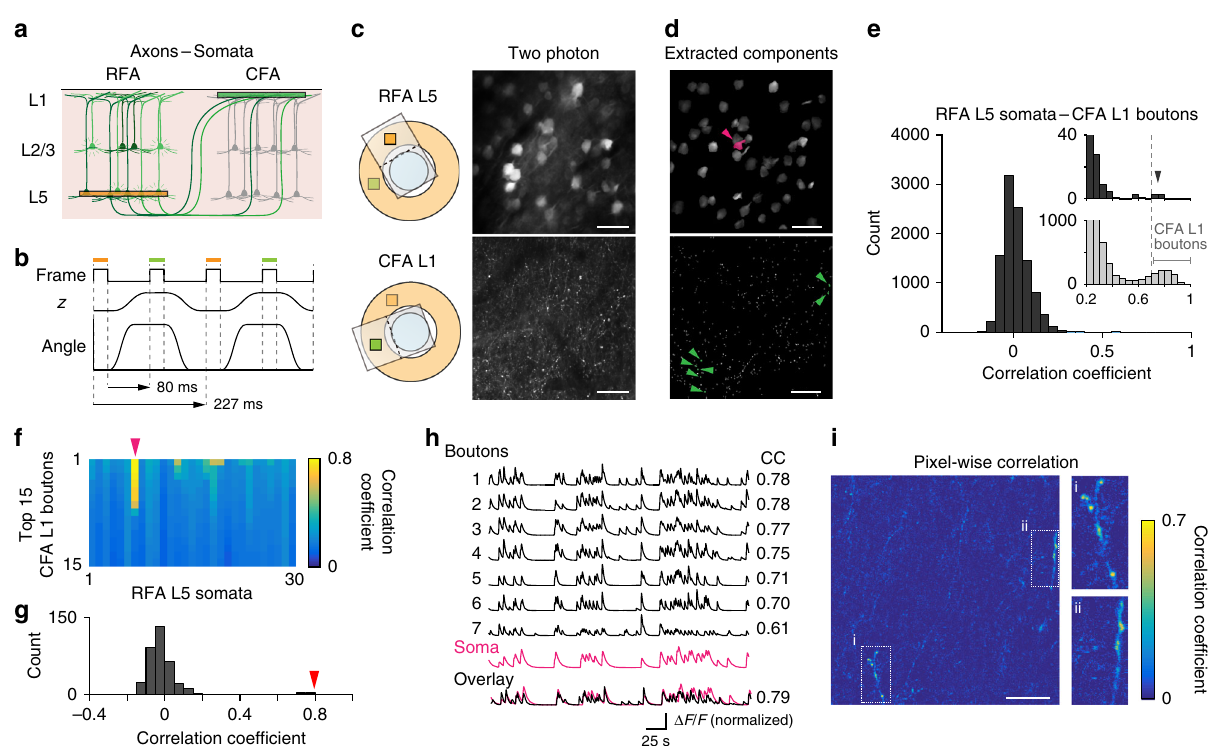
Fig. 6 Dual- fi eld imaging of neuronal somata and their projecting axons. a Schematic illustration of imaging fi elds (green, CFA; orange, RFA). b Timing chart during four consecutive imaging frames. c Left, schematic illustration of the FOV and device position at each imaging frame. Right, averaged two-photon images of GCaMP6s-expressing neuronal somata and axons. The depths of the fi elds in RFA L5 and CFA L1 were 450 and 25 µ m, respectively. Scale bar, 50 µ m. d All spatial components were extracted using the CNMF algorithm. Each component properly captured the structure of the neuronal soma and axonal bouton. Scale bar, 50 µ m. e Histogram of pairwise correlation coef fi cients (CCs) in inferred spike events between the RFA L5 somata and CFA L1 boutons with >10 spike events. The upper right inset is an enlarged view of the histogram. The right middle inset is a histogram of CCs between CFA L1 boutons (gray bars). f CFA boutons with the top 15 CCs against each RFA soma are sorted in descending order of the CC values. A magenta arrowhead indicates the same neuronal soma as in d . g Histogram of CCs of the RFA L5 somata indicated by the magenta arrowhead in d and f against all CFA L1 boutons. A red arrowhead indicates the position of the top CCs (0.78). The standard deviation of the distribution was 0.12. h Representative Δ F/F (temporal components) traces of seven CFA boutons (black) that showed high CCs against the trace of the neuronal soma shown in g (magenta). The amplitude was normalized to the maximum Δ F/F . Positions of the soma and boutons are indicated in d . The number to the right of each trace is the correlation coef fi cient (CC) with the soma. i Left, map of pixel-wise correlations between raw fl uorescent traces in the CFA L1 imaging fi eld and temporal component traces of the RFA L5 neuronal soma indicated in d . To improve the signal-to-noise ratio, 5-frame moving averages of the raw fl uorescent traces in the CFA L1 fi eld were used. Right, enlarged maps of the two boxes shown in the left panel. Scale bar, 50 µ